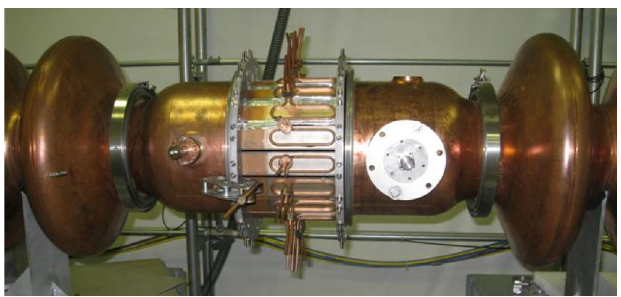
FIG. 25. Ferrite HOM damper installed between two five-cell Cu